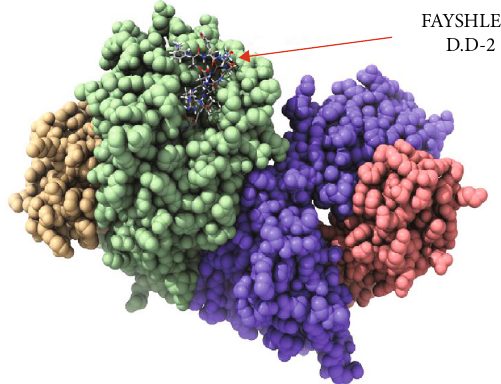
Figure 9: Molecular docking of FAYSHLERI peptide of Nipah virus docked in HLA-A ∗ 02:01 and visualized by UCSF Chimera X version 0.1.0. ∗ D.S: Docking Side